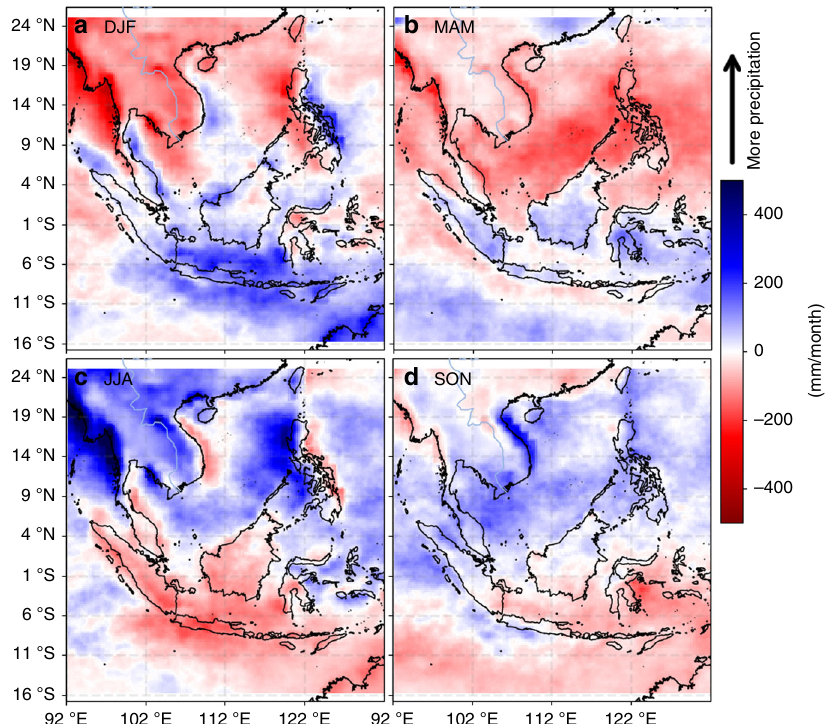
Fig. 4 Composite seasonal maps of precipitation anomalies. a – d correspond to the maps for the DJF, MAM, JJA, and SON